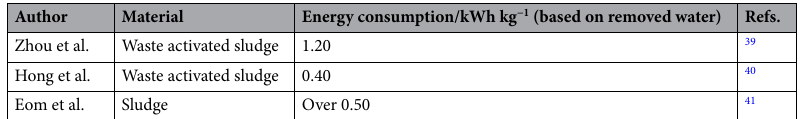
Table 3. Energy consumption by thermal drying in